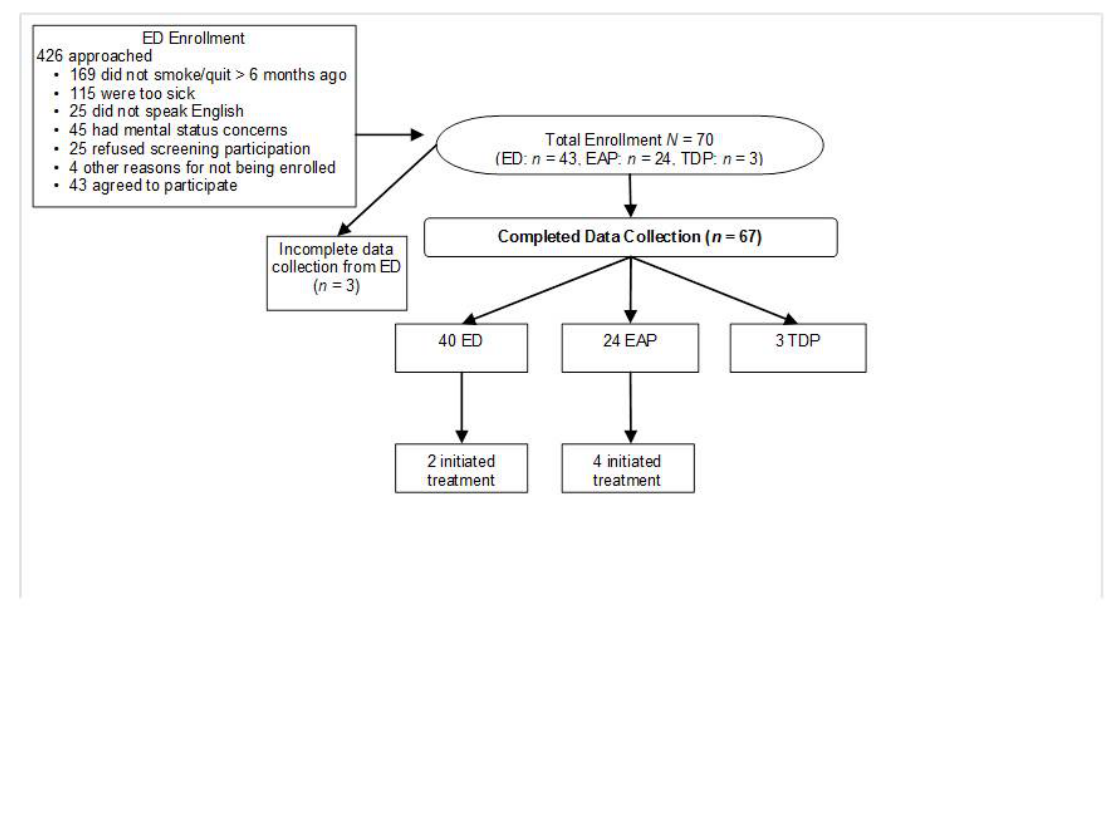
Figure 6. Enrollment of participants in the Field Evaluation Study of the CABIT program. Participants were recruited from the Emergency Department (ED), Employee Assistance Program (EAP), and Tobacco Dependence Program (TDP). Screening data was only available for participants from the emergency department. Follow-up was not completed with patients in the tobacco dependence program as they were already receiving treatment. Treatment initiation was confirmed through contact with tobacco dependence specialists in the referral